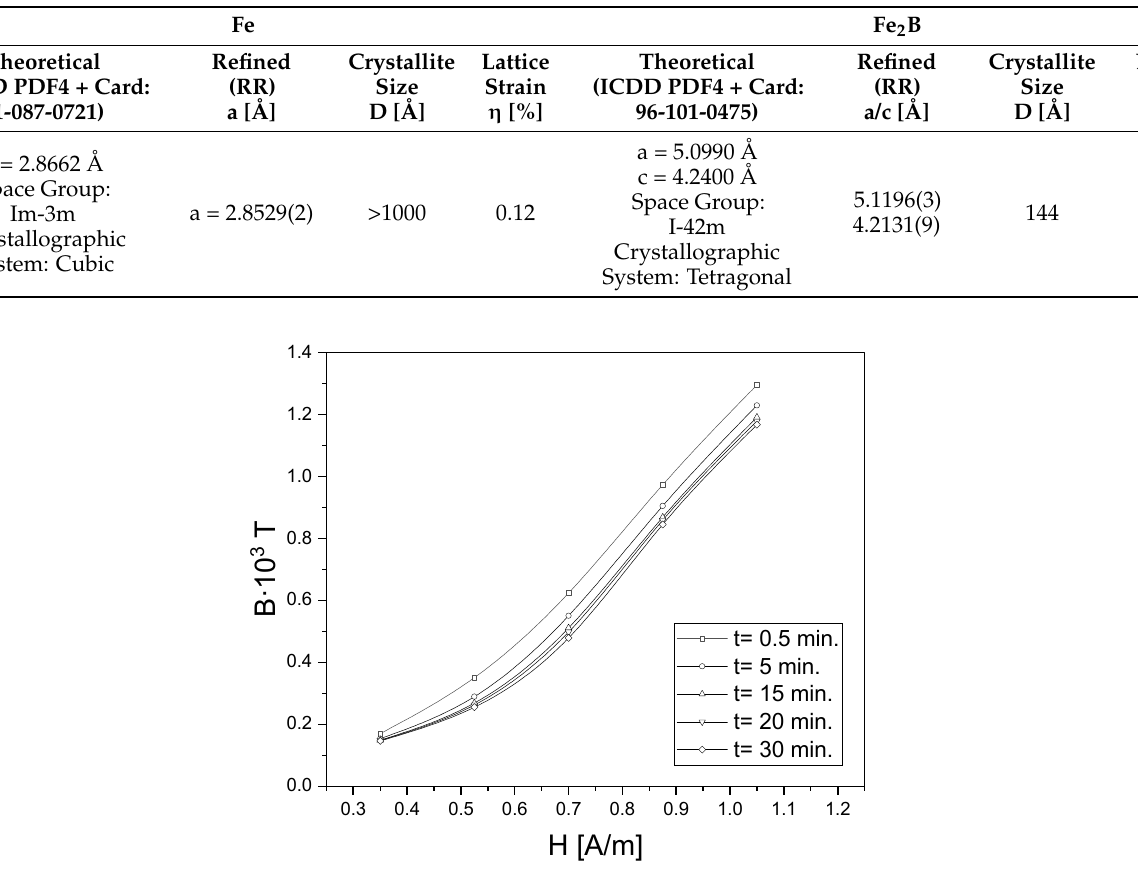
T op Figure 5. Isochronal magnetic permeability curves versus the 1 h annealing temperature. The magnetic aftereffects curves versus the 1 h annealing temperature are presented in Figure 6. The quantity Δ μ / μ is proportional to the concentration of relaxators.